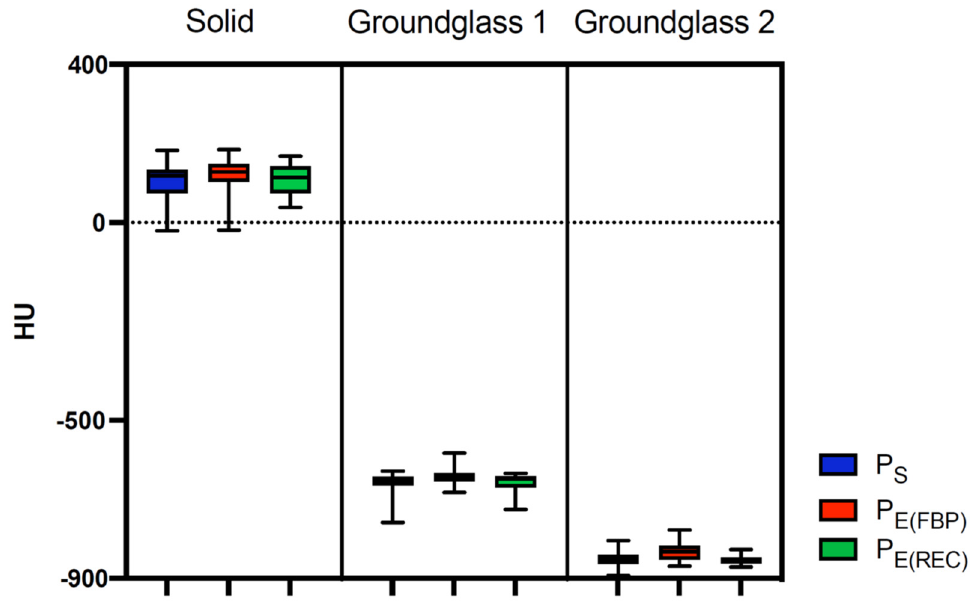
Figure 7. Box-plot diagram of measured CT attenuation according to scanning protocol and nodule density. The graph visualizes the spread of observed attenuation (HU, Hounsfield Units) among different factual nodule densities and scanning protocols. Colors represent the utilized scan proto- col. Institute-specific standard low-dose protocols (P S ), ESTI protocols (P E ) reconstructed with fil- tered back projection (P E(FBP) ) as well as iterative reconstruction (P E(REC) ) were compared.